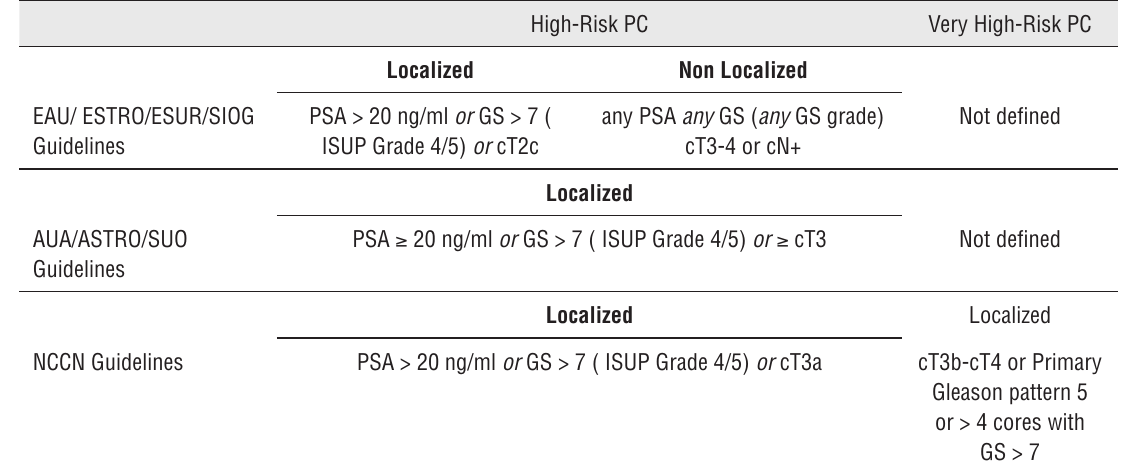
Table 1 - High Risk Prostate Cancer definition criteria according to different Guidelines